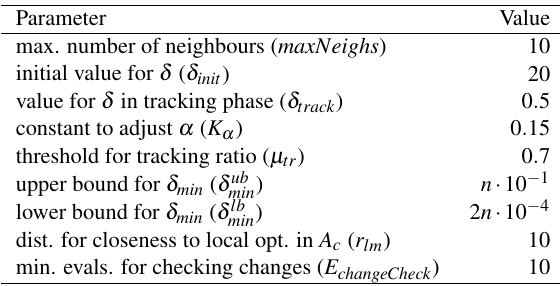
Table 2. Parameter setting for the adaptive local